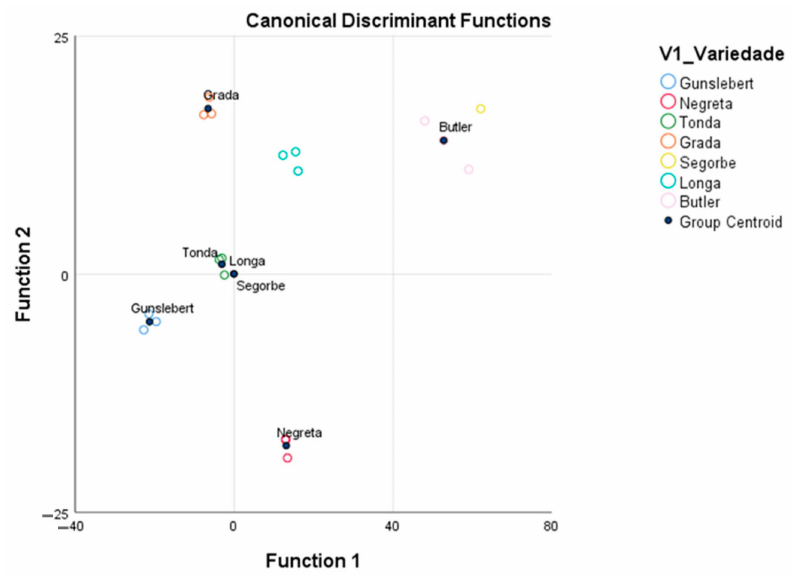
Figure 1. Discrimination of the seven varieties studied according to the two most important functions: F1 and